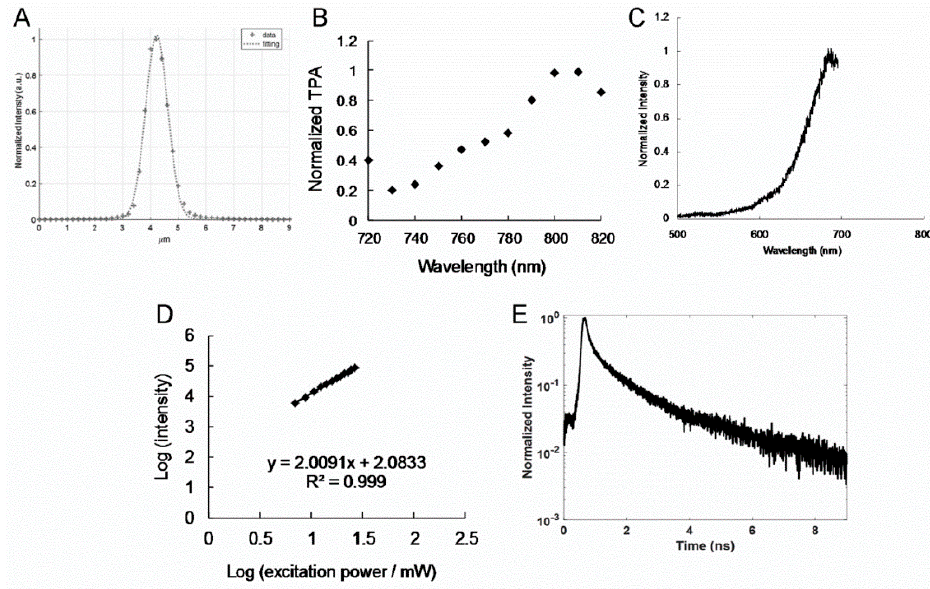
Figure 3. ( A ) According to the z -axis scan of a gold thin film for measuring the signal of second harmonic generation at different positions, the z -axis resolution of the laser system (full width at half maximum) was approximately 0.94 µm (fitting performed using the Gaussian function). ( B ) Relative TPA spectrum of the amino-N-GQD (6.2%)-polymers. Signals were observed through TPE at various wavelengths (720–820 nm) at 70.4 nJ pixel − 1 . ( C ) Relative TPL spectrum of the amino-N-GQD